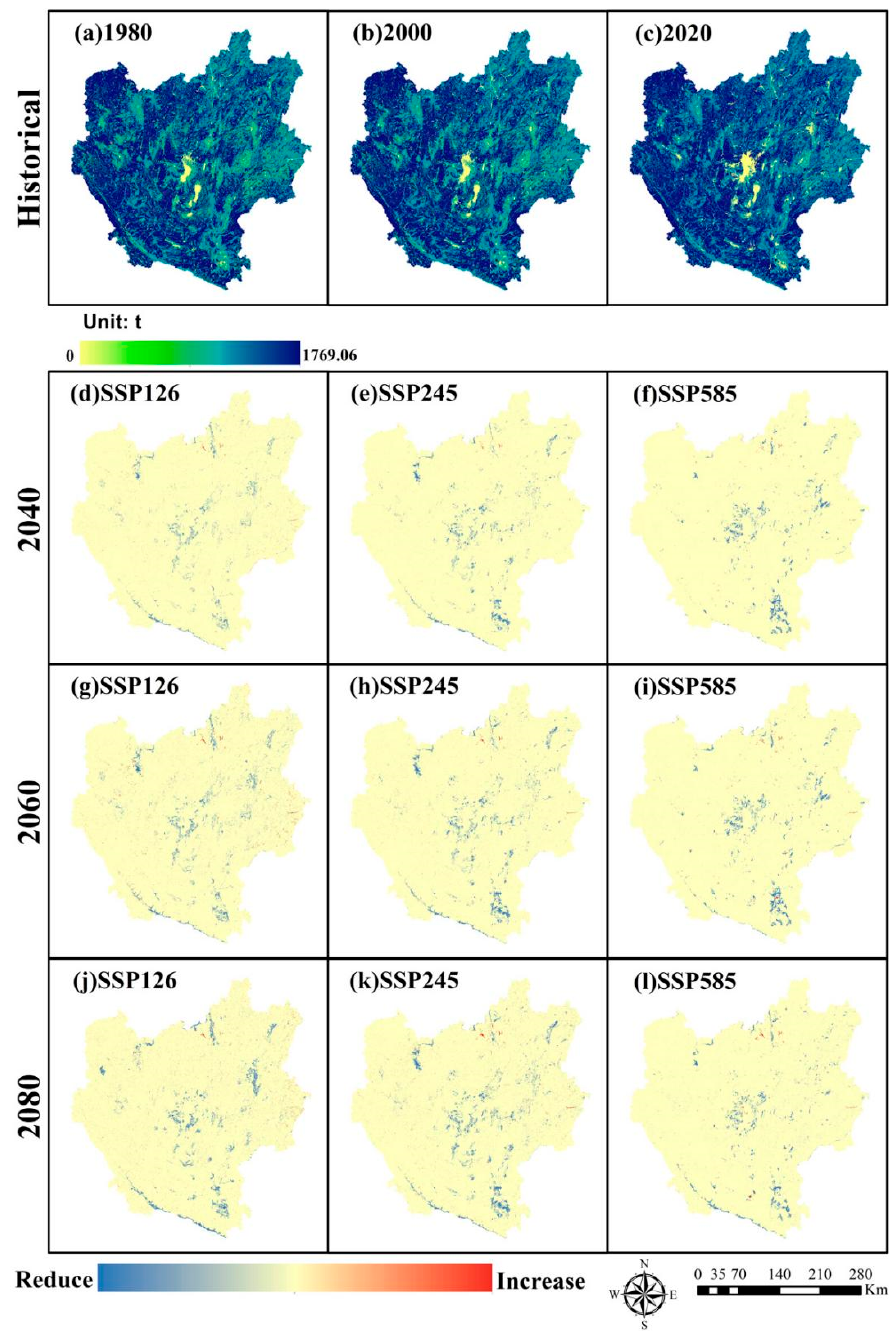
Figure 8. Spatial distribution of carbon storage in the ( a – c ) historical period, and spatial changes in the ( d – l ) future period relative to